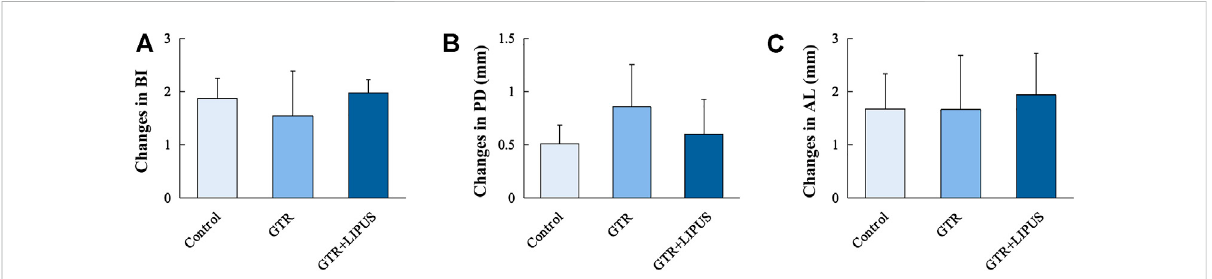
FIGURE 2 Clinical periodontal parameters of different groups. BI (A) , PD (B) , and AL (C) of the control group, GTR group, and GTR+LIPUS group. Data are presented as mean ± SD.